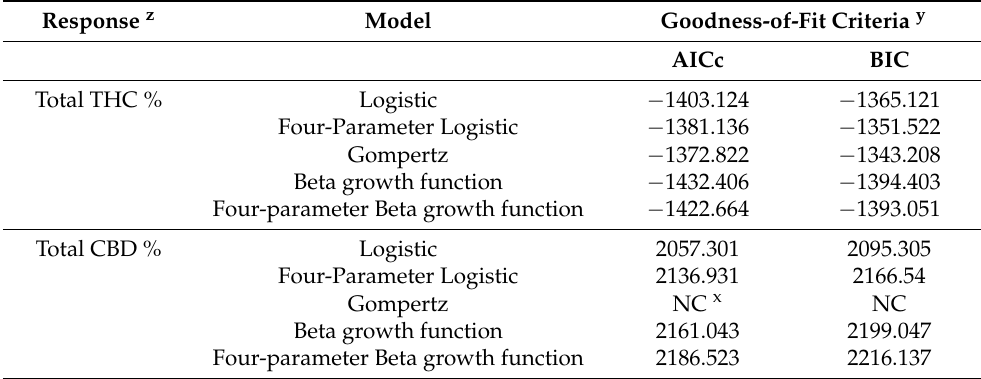
Table 3. Goodness-of-Fit criteria for mixed nonlinear sigmoid models describing the relationship between floral hemp total THC and CBD concentrations over time.